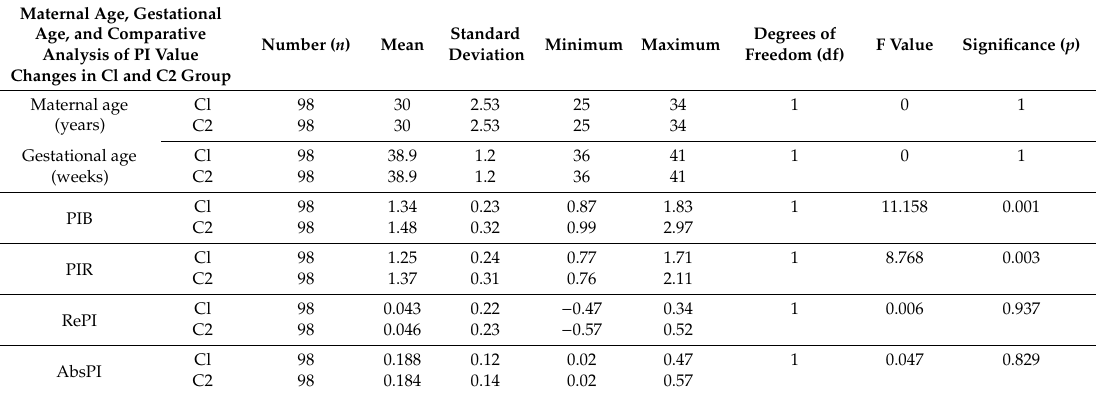
Table 1. Comparative analysis of maternal age, gestation week, absolute PI (AbsPI) changes, and relative PI (RePI) changes in groups C1 and C2.